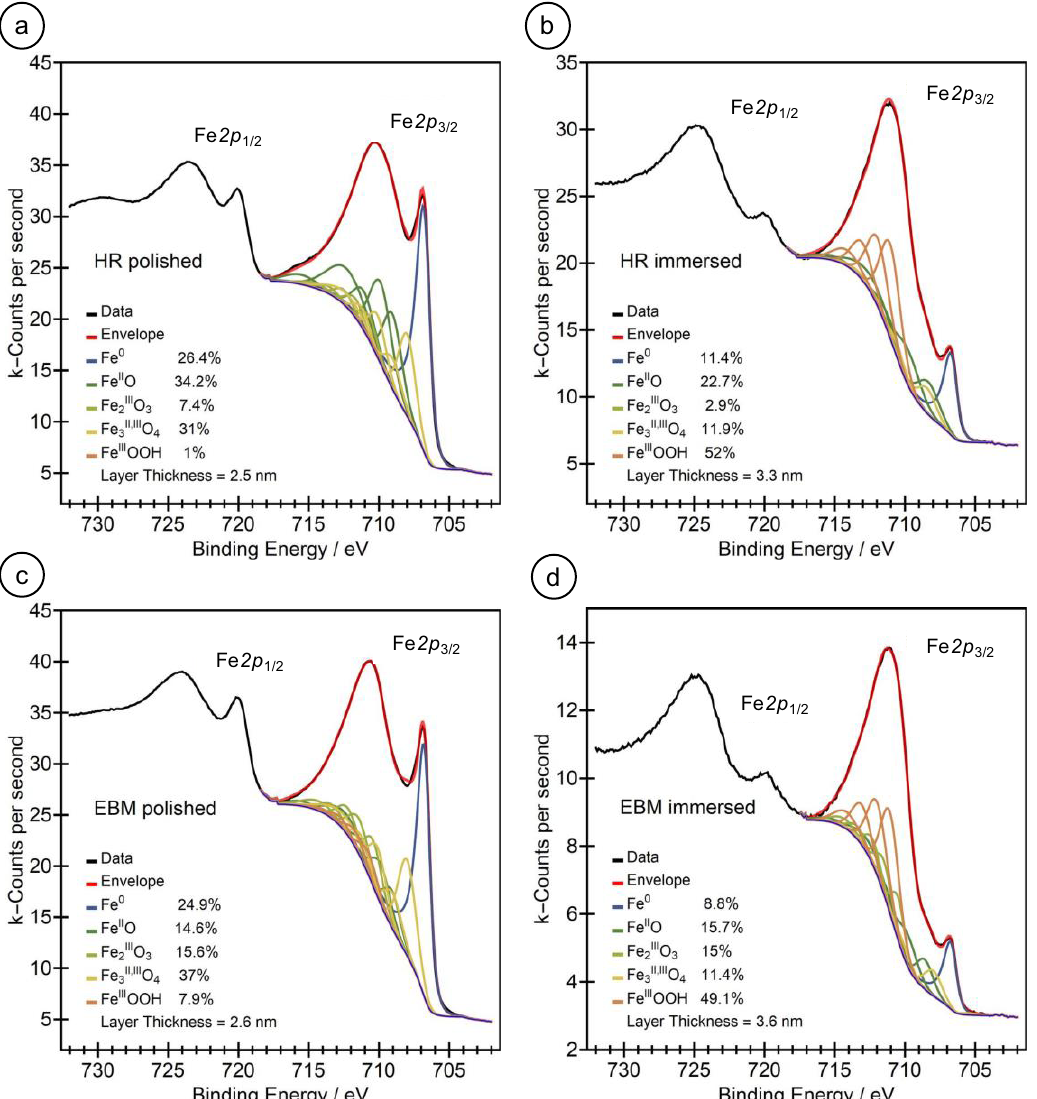
Fig. 12 Fe2 p element spectra of as-prepared (polished, etched) samples in comparison to the surface states after 24-h immersion in m-SBF. Shown for a , b HR iron and c , d EBM iron.